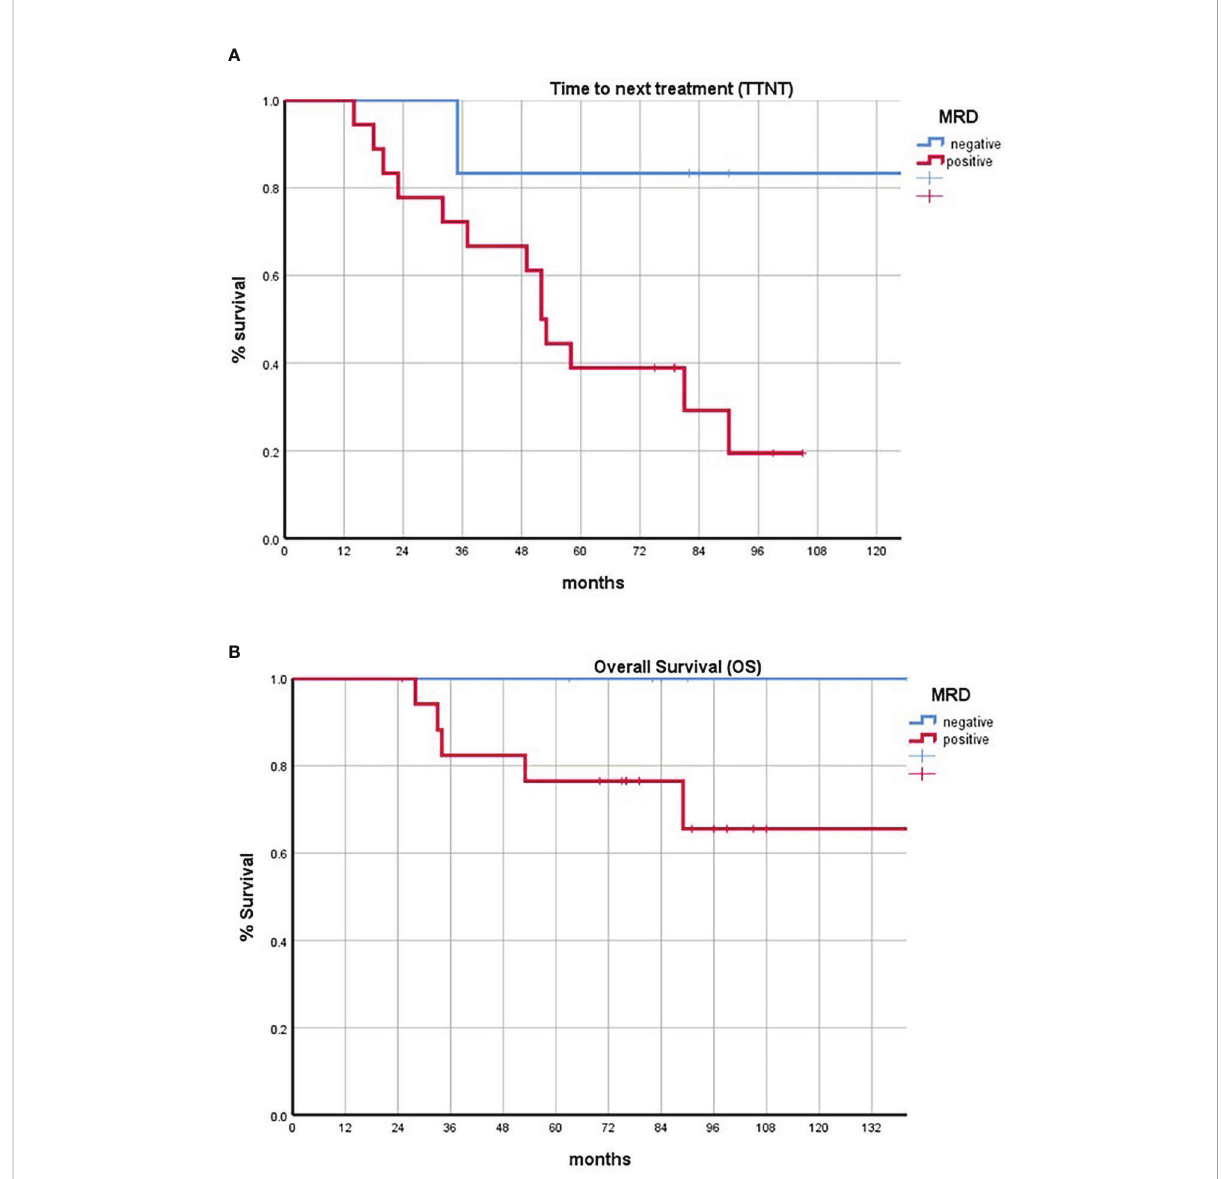
FIGURE 1 (A) Kaplan – Meier curves comparing the time to next treatment of minimal residual disease (MRD)-positive and MRD-negative subsets. (B) Kaplan – Meier curves comparing the overall survival of MRD-positive and MRD-negative subsets. Negative patients are represented in blue; positive patients are represented in